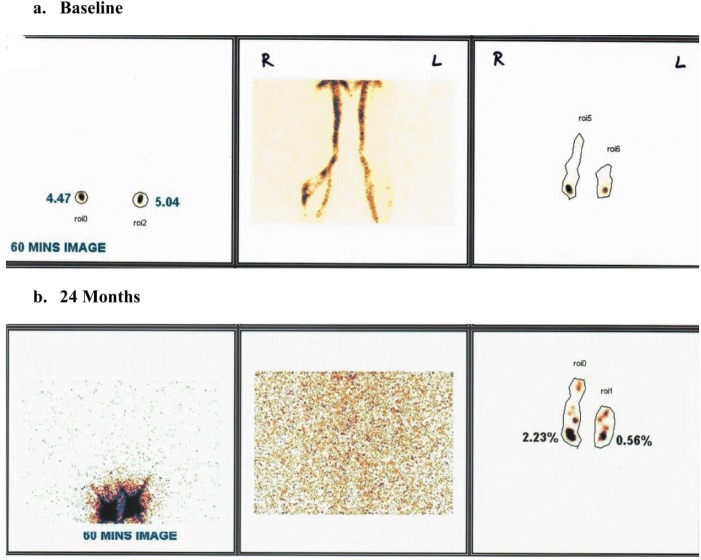
a & b: Baseline and 24 month images showing disappearance of tracer retention in collateral lymphatic channels and overall improvement in lymphatic flow. Leg images are normal at 24 months. (a) baseline. (b) 24 months.